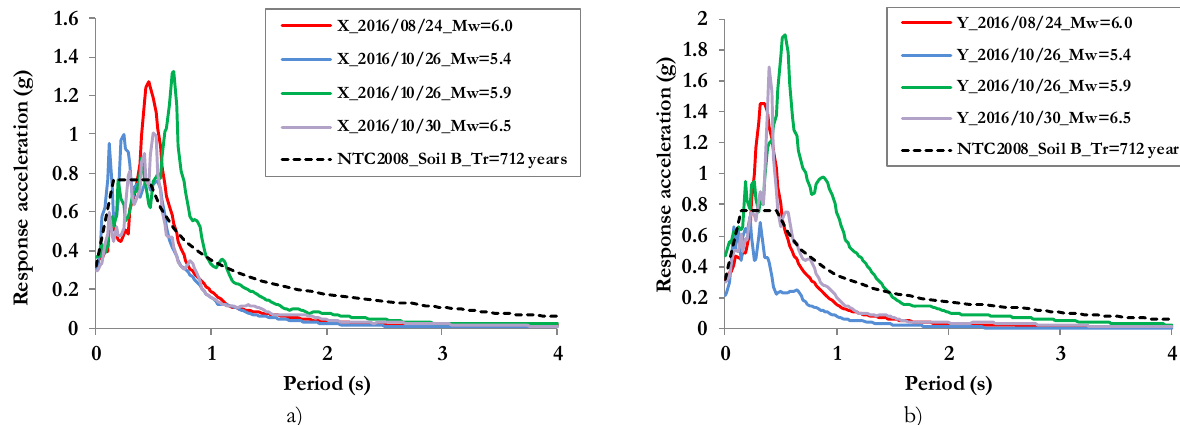
Figure 8: Comparison between the response spectra of the seismic events of August 24 th , October 26 th and October 30 th and the elastic spectrum of NTC2008 for soil B and return period Tr=712 years (damping 5%): a) X component, b) Y component.